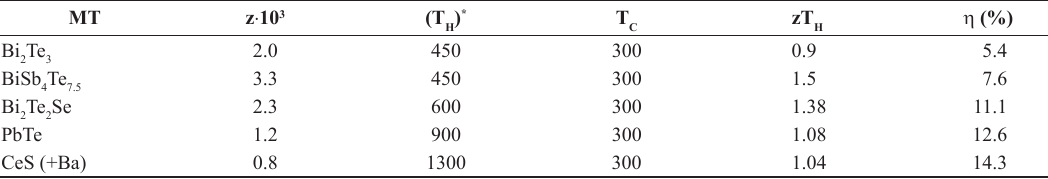
Table 3. Performance and “efficiency” of some TMs5.